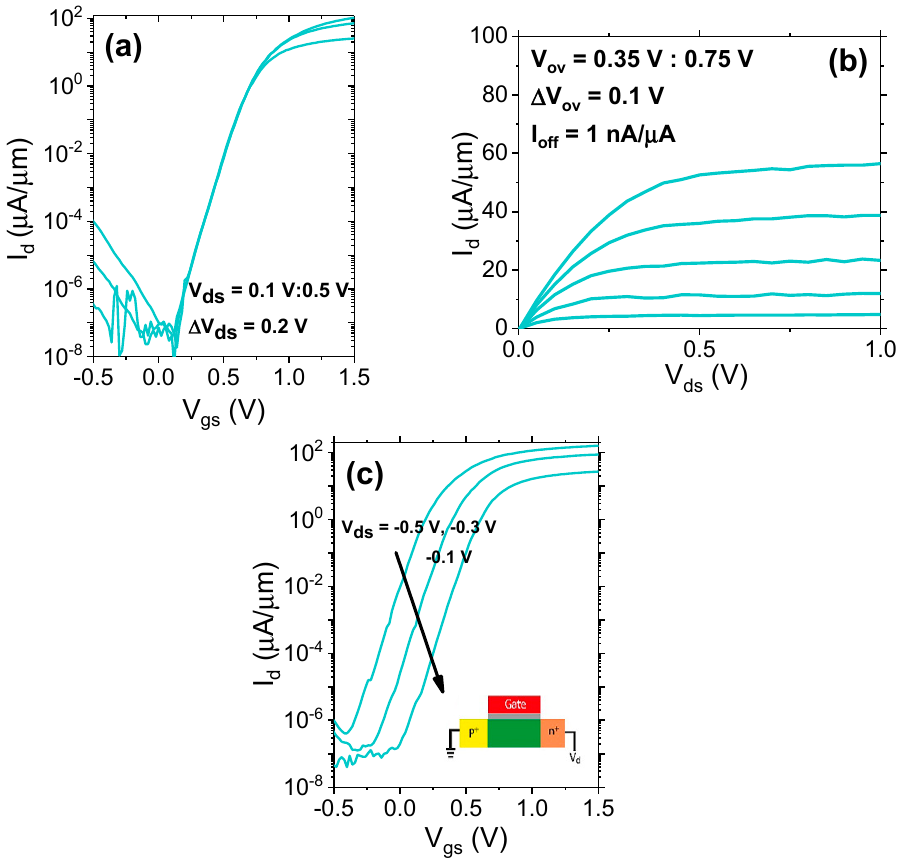
Figure 5. Measurement results of Set 3 devices: ( a ) Transfer characteristics I d -V g of the optimized n-TFET, ( b ) corresponding output characteristics I d -V ds of the fabricated device showing good saturation and linear onset. The device shows very high on-currents of 15 µ A/ µ m at V dd = 0.5 V. ( c ) Forward biased I d -V gs characteristics of the p-i-n diode, showing typical forward I-V curves for the diode.